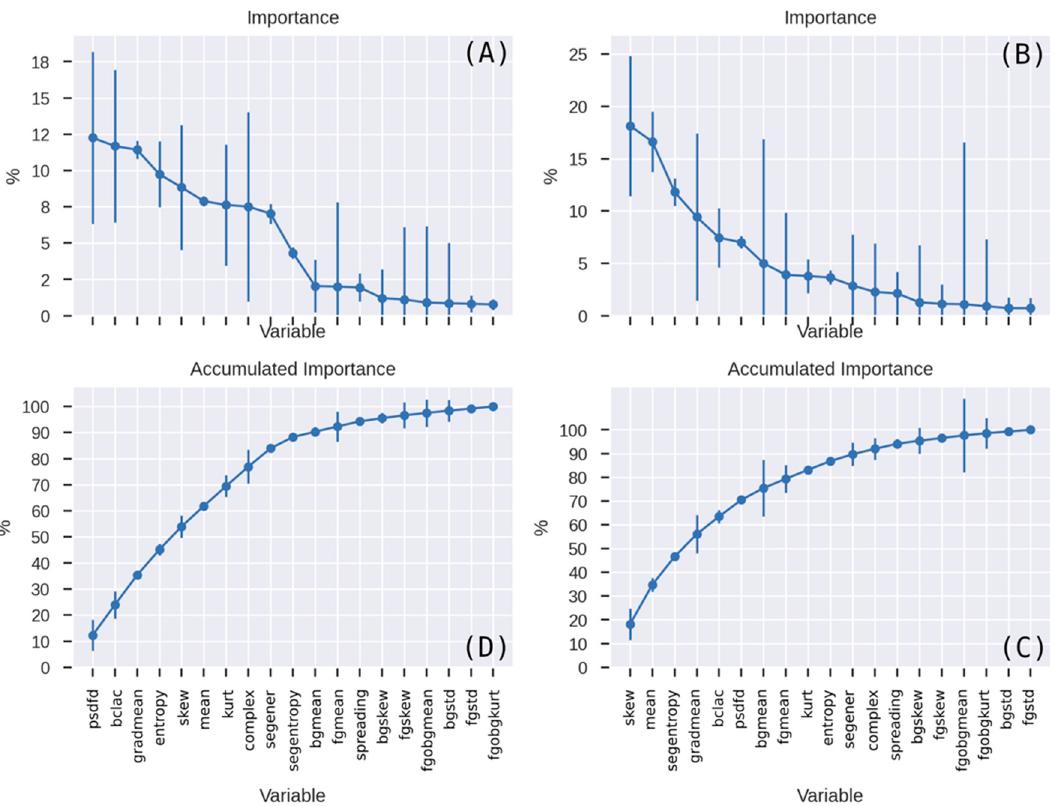
Figure 6. Random forest feature importance for the seven-label ( A ) and the oil detector ( B ) classification problems. Below ( A ) and ( B ), accumulated feature importance can be seen at ( C ) and ( D ). Error bars are feature importance standard deviations among the random forest’s trees.